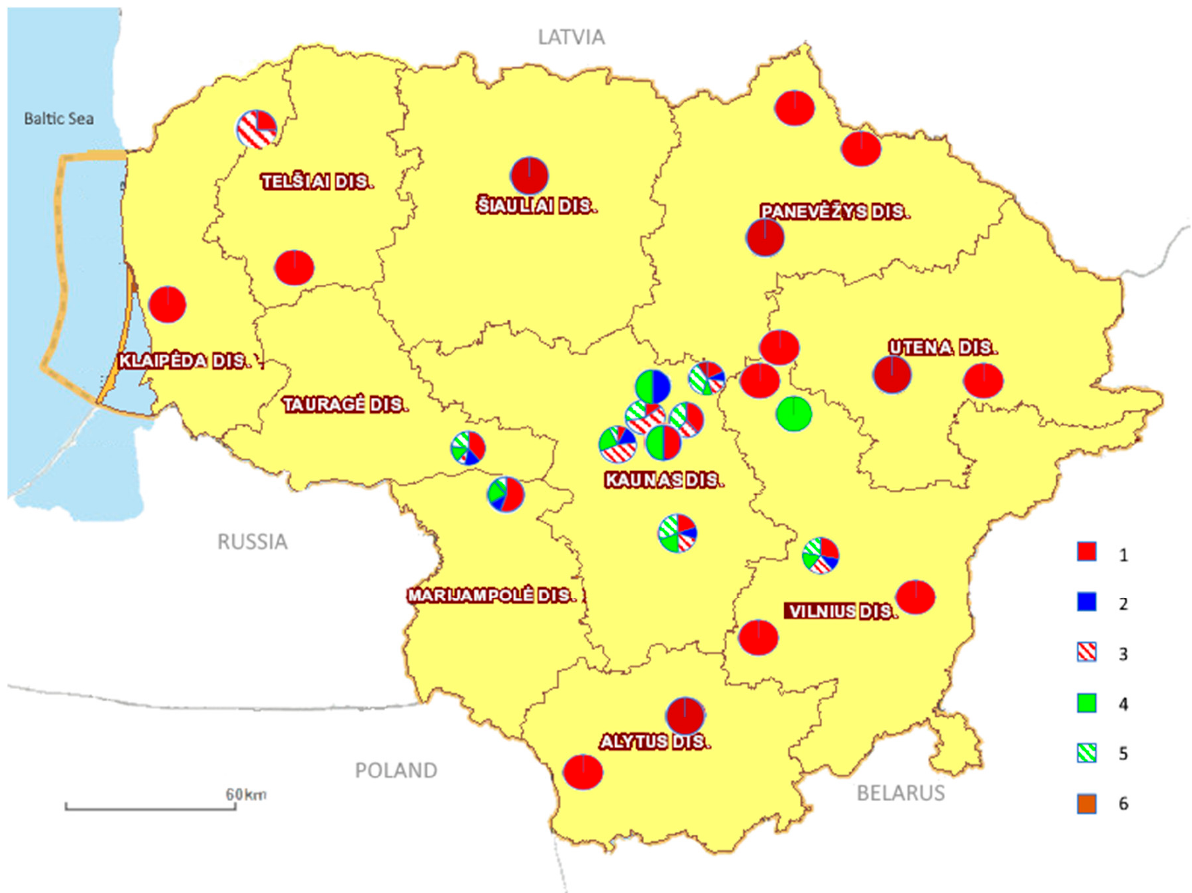
Figure 1. The sample collection sites of studied elm species and hybrids in Lithuania. The color in the pie charts refers to the elm species: 1— U. glabra ; 2— U. minor ; 3— U. glabra × U. minor ; 4— U. minor subsp. Minor ; 5— U. minor subsp. minor × U. glabra ; and 6— U. laevis .